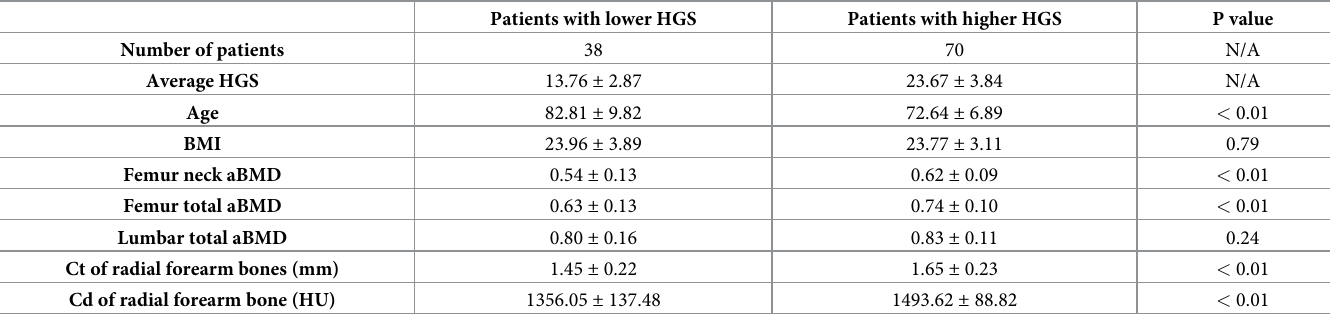
Table 3. Results obtained from the independent t-test between the patients with lower HGS and those with higher